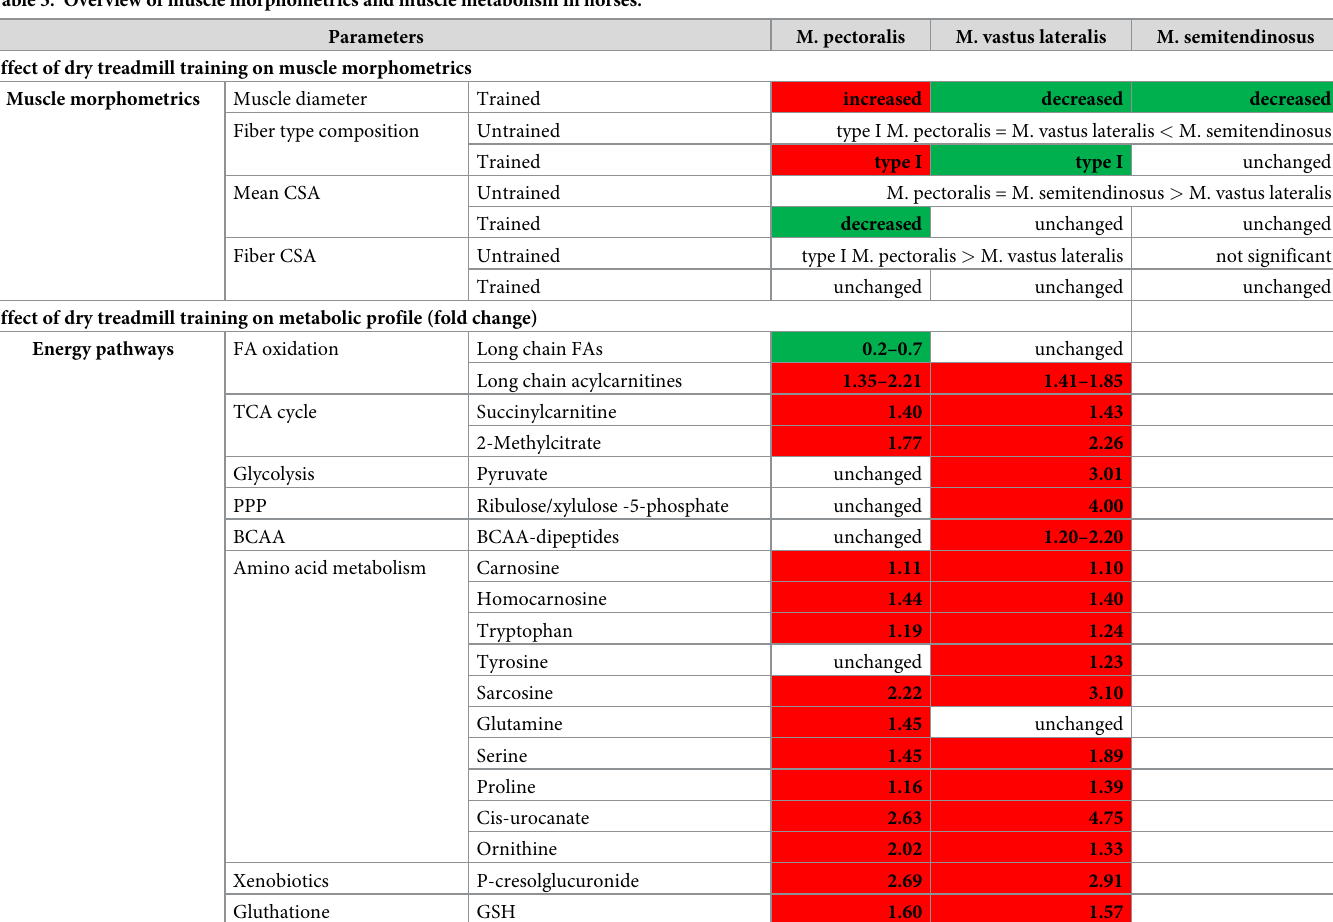
Table 3. Overview of muscle morphometrics and muscle metabolism in